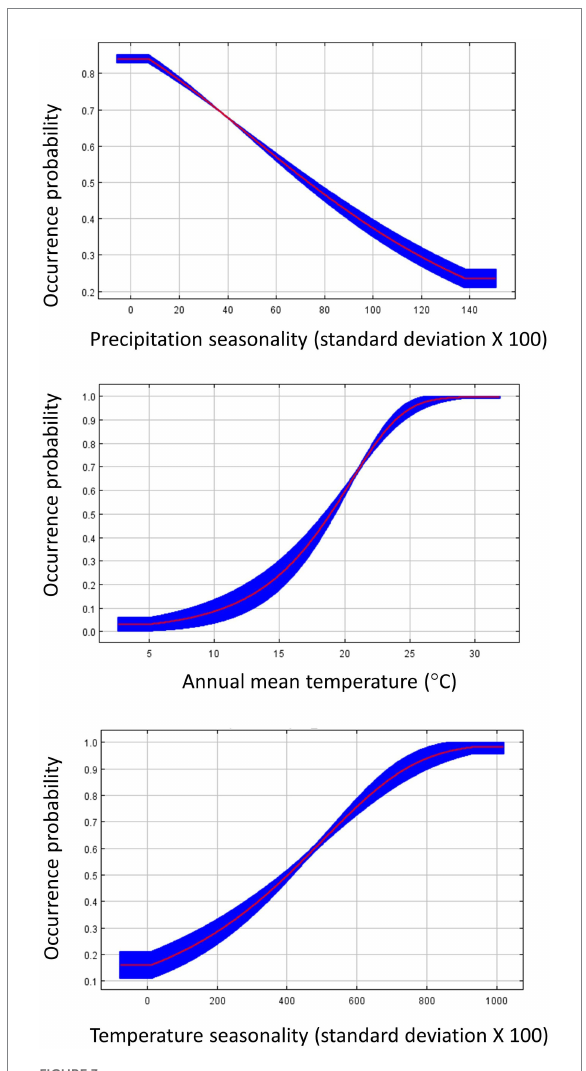
FIGURE 3 Response curves for influential environmental variables from the species distribution model predicting Dickcissel occurrence during spring migration. The response curves were generated in Maxent, and show how the predicted occurrence probability changes with each variable, while keeping all other variables at their average sample value. The red line plots the average value of the five model replicates, and the blue area plots the variance among the five